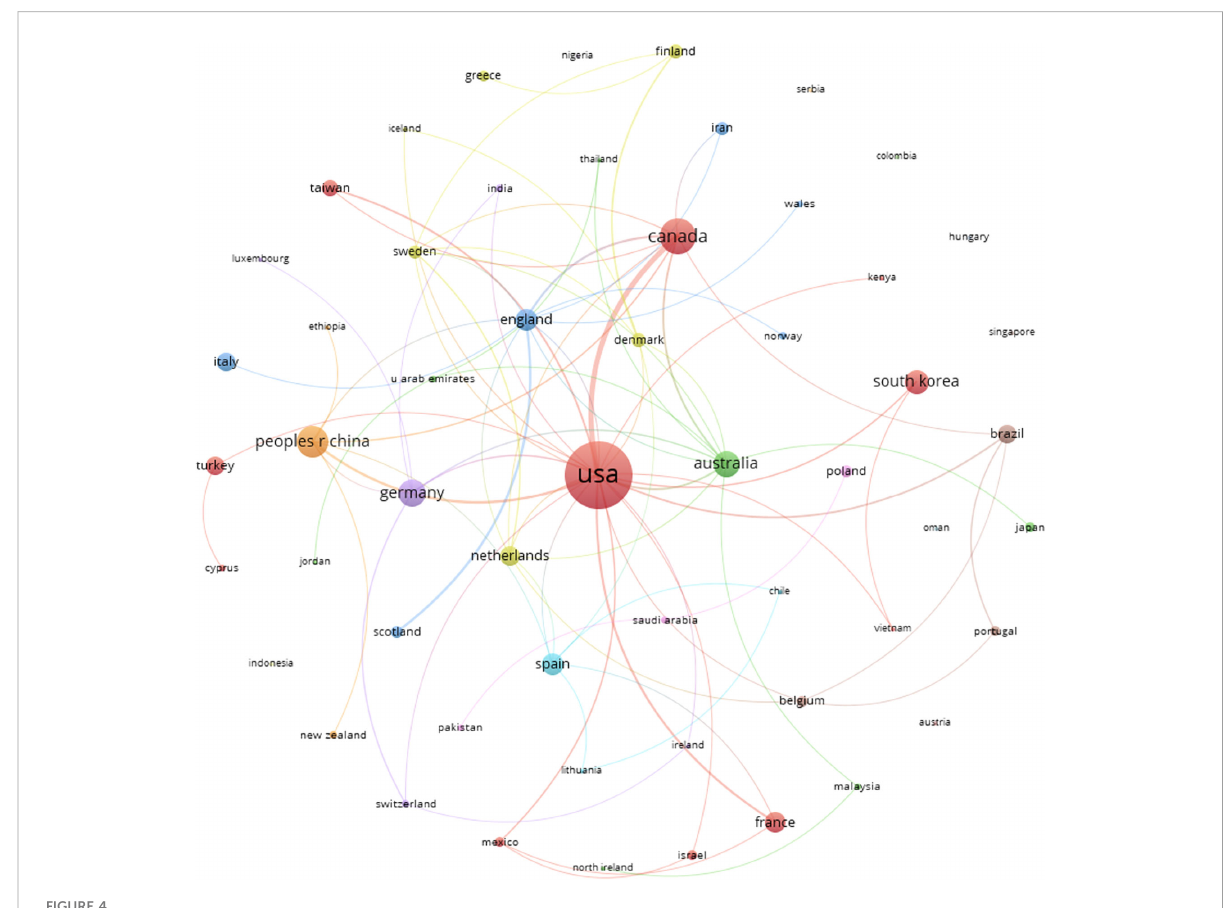
FIGURE 4 Countries in co-authorship and their